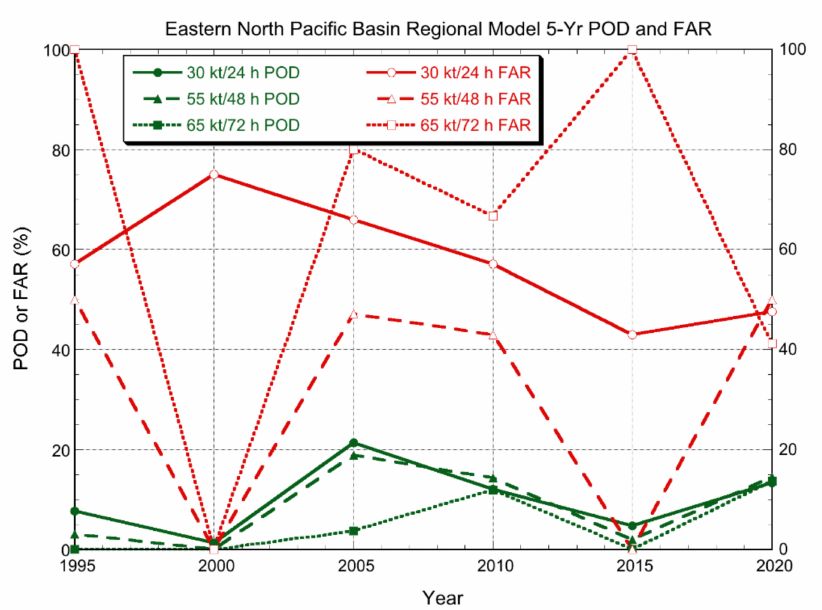
Figure 3. As in Figure 2, but for the eastern North Pacific. The regional models evaluated here were GFDL from 1993–1995, GFDI from 1996–2005, and HWFI from 2007–2020 (no GFDL forecasts were available in 1991–1992 and no HWFI forecasts were available in